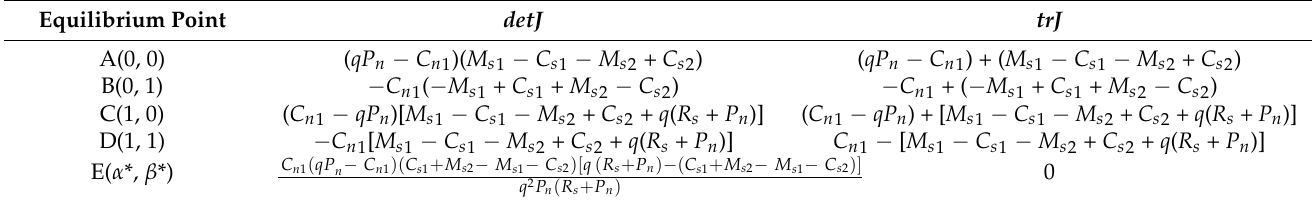
Table 2. The analysis table for judging the stability of equilibrium points between local government and coal-related